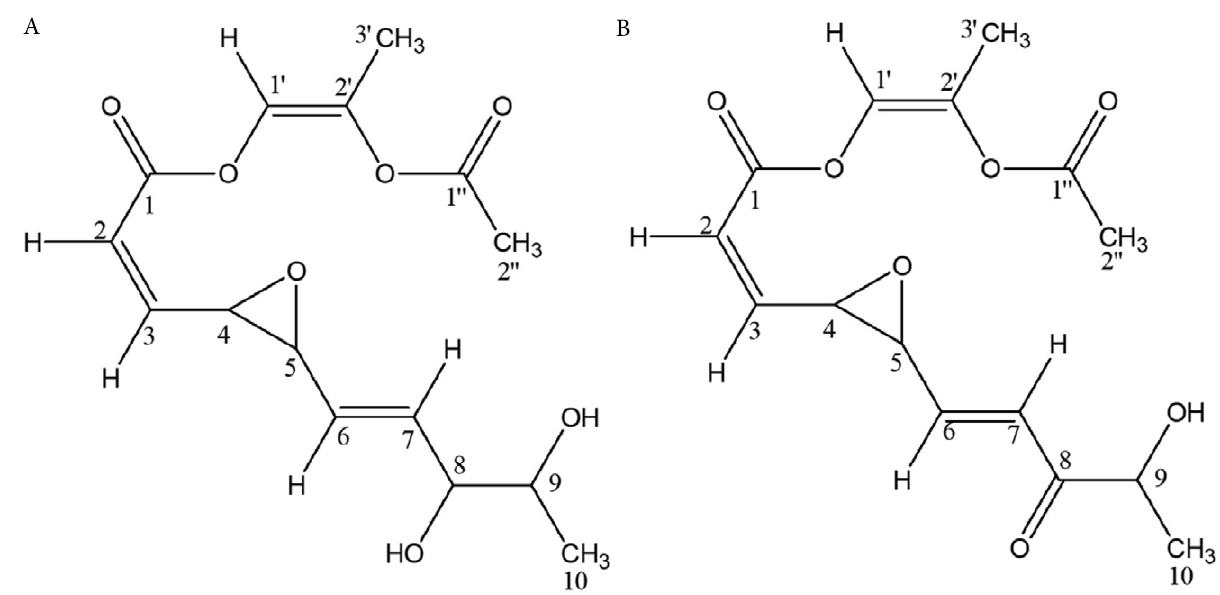
Figure 7. Molecular structures of compounds 325-3 (A) and 325-5